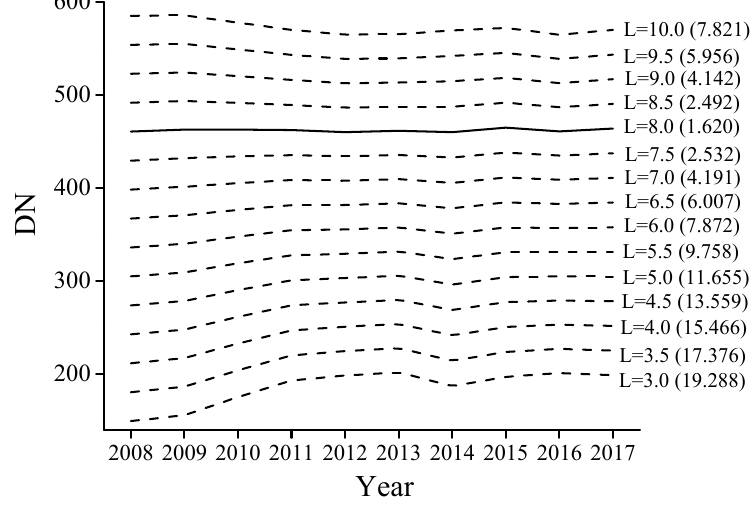
Figure 10. Response changes of IRS B08 at di ff erent radiance. “L” represents the radiance in unit of W · m − 2 · sr − 1 · µ m − 1 Numbers in brackets are the corresponding root mean square error of DN in di ff erent years. Digital number (DN) values were calculated when the radiance range from 3.0 to 10.0 W · m − 2 · sr − 1 · µ m − 1 .